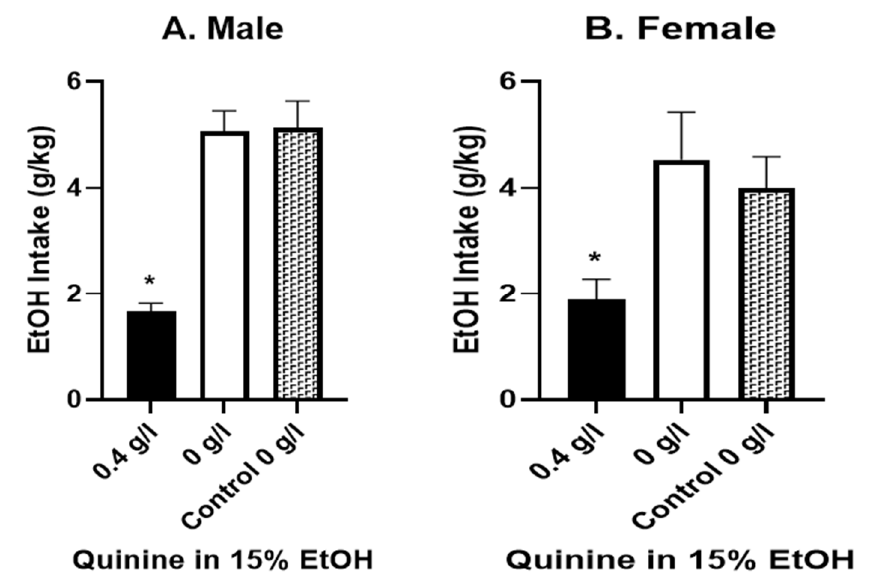
Figure 2. Quinine Effect on First Day of EtOH Drinking. Black bars: intake on the first day of exposure to 15% EtOH containing 0.4 g/L quinine; white bars: intake of 15% EtOH without quinine on the following day; hashed bars: intake of control rats (15% EtOH only) on the first day of EtOH access. Adulteration with 0.4 g/L quinine robustly reduced intake of EtOH in males ( A ) ( n = 5; t = 11.09, * p < 0.001, paired t -test vs. white bar; * p < 0.001 vs. control group—hatched bar; unpaired t -test) and females ( B ) ( n = 7; * p < 0.03, paired t -test vs. white bar; * p < 0.03 vs. control group—hatched;